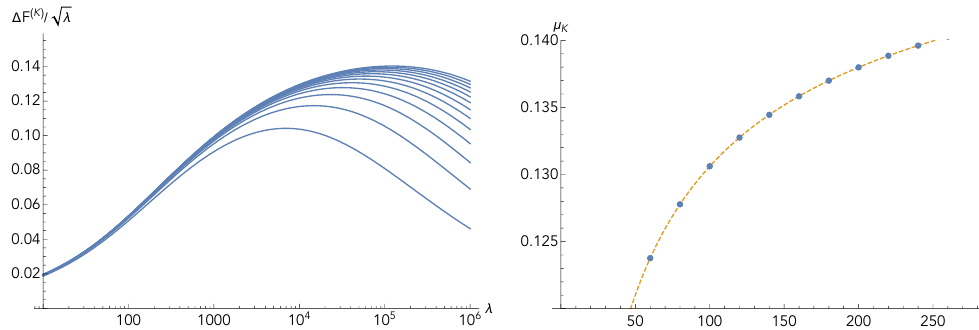
Figure 5 . Analysis of ∆ F by considering a truncated leading order approximation of the matrix M . √ In the left panel we plot the ratio ∆ F K / λ where F K is defined in (6.8), and K = 20 , 40 , . . . , 260 from bottom to top. For each K , there is a maximal value µ K . In the right panel we plot µ K vs. K (blue dots) and compute its best fit (orange dashed line) with a constant plus a leading ∼ K − 1 / 2 and subleading ∼ K − 1 terms. The best fit parameters are in